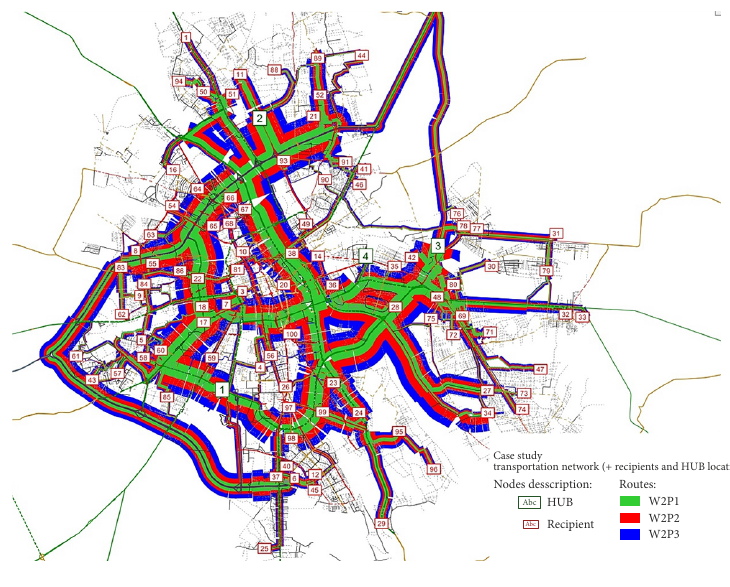
Fig. 3. Routes in variant 2